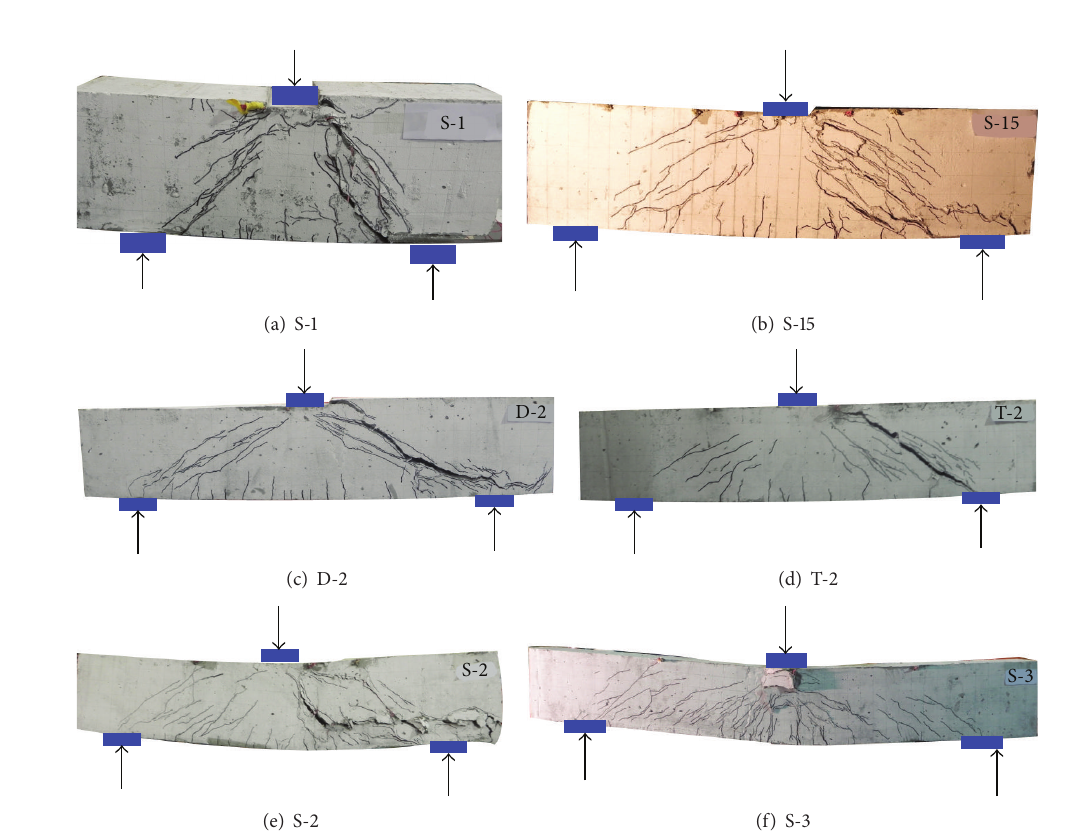
Figure 3: The failure pattern of